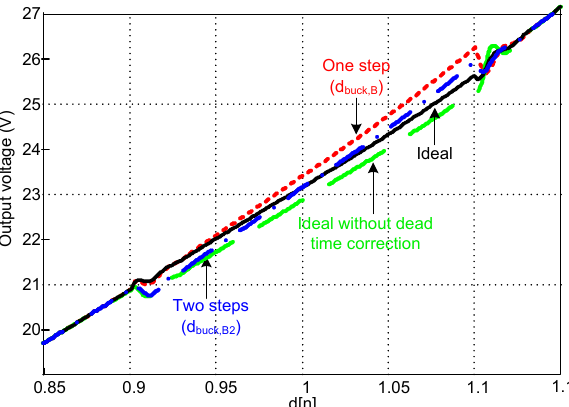
Figure 16. Comparison between the output voltage simulation obtained using the different pre- sented implementations of the state machine to define d buck [n] and d boost [n] depending on the oper- ation mode.